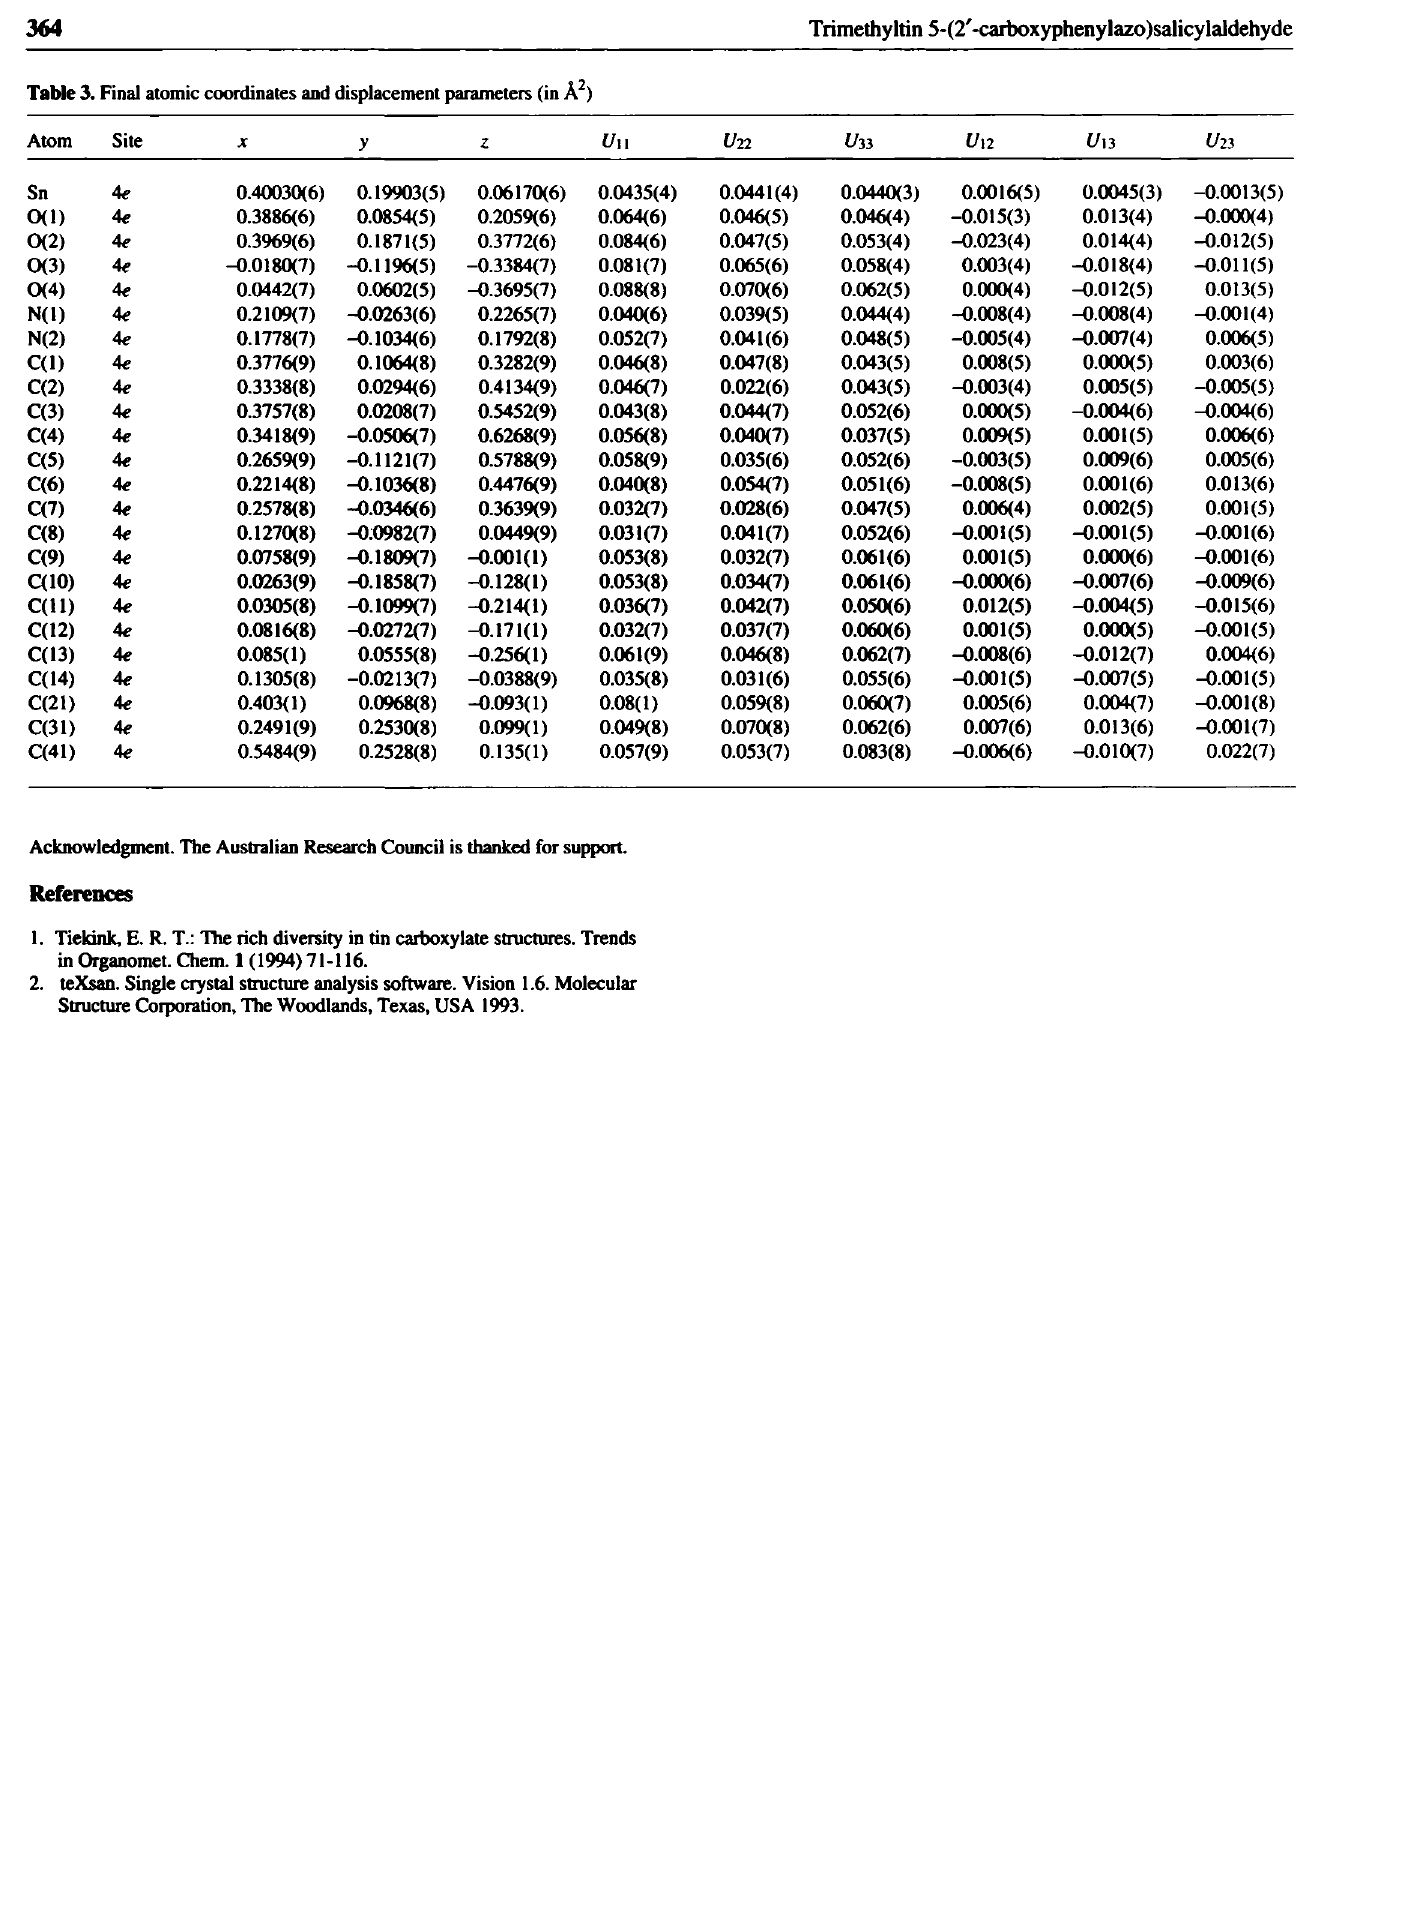
Table 3. Final atomic coordinates and displacement parameters (in Â 2